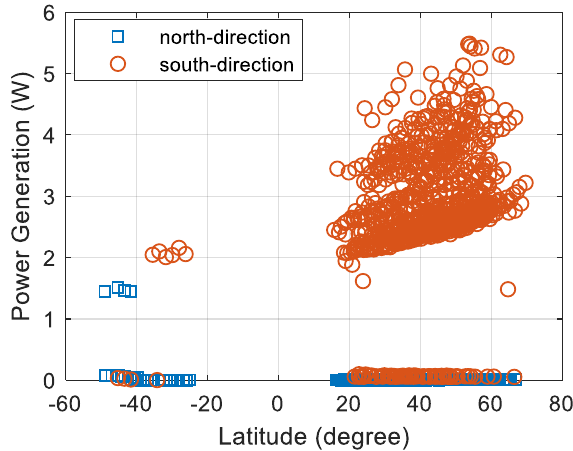
Figure 7. Power generation according to the latitude (December 2018).